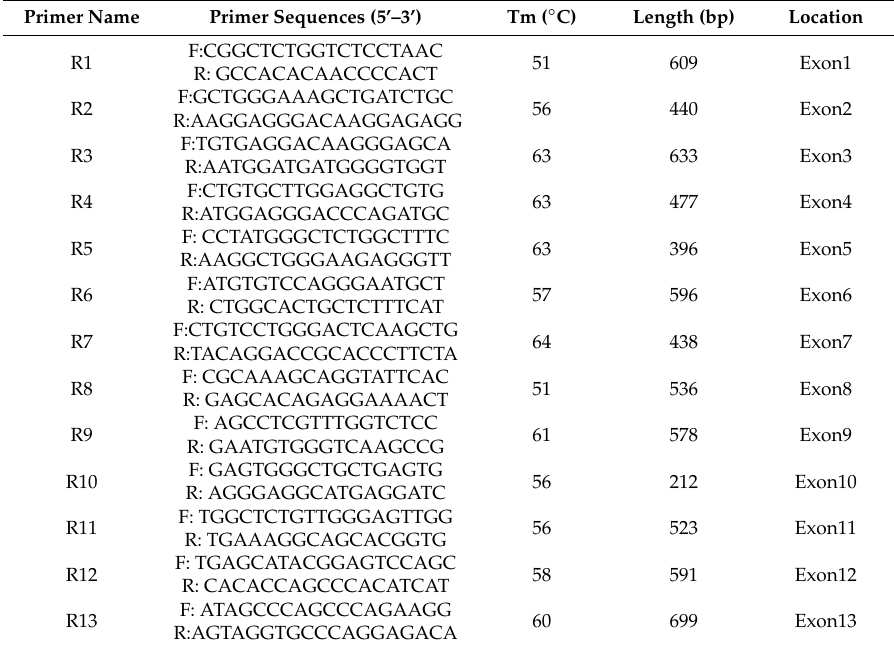
Table 1. Primer information of the bovine RET